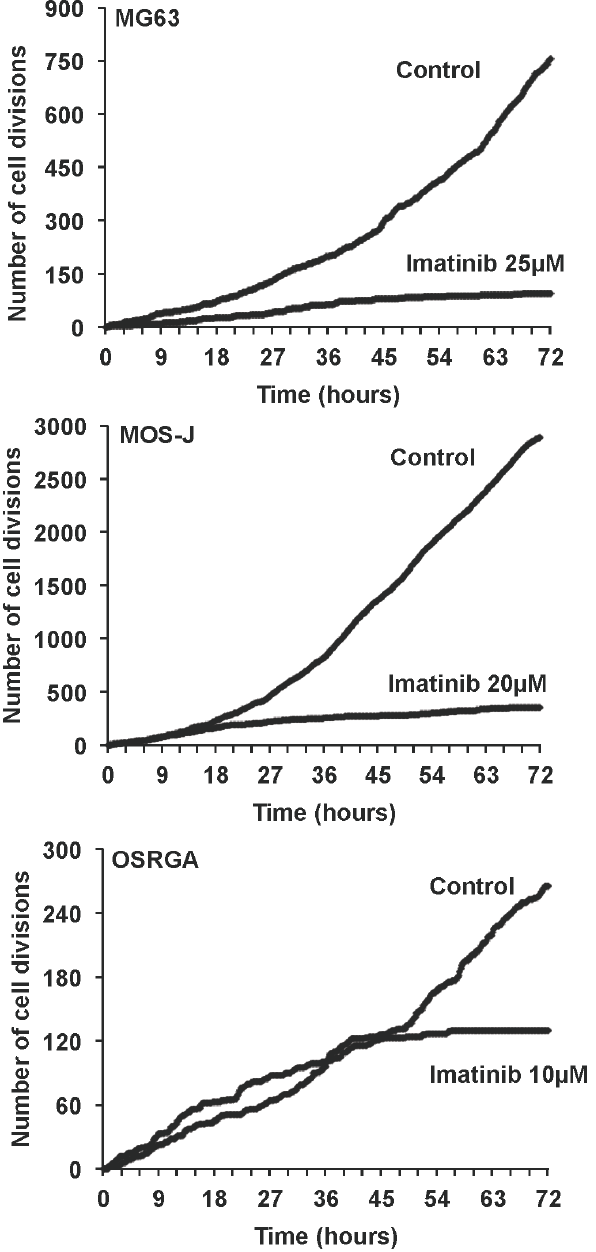
Figure 2. Inhibitory effect of imatinib mesylate on osteosarco- ma cell mitosis. Human MG63 ( A ), mouse MOS-J ( B ) and OSRGA ( C ) osteosarcoma cells were cultured in the presence or absence of imatinib mesylate with 25 m M, 20 m M and 10 m M respectively. Phase- contrast photos were taken every 10 minutes for 72 hours and the number of cell mitosis manually scored in a time-dependent manner. doi:10.1371/journal.pone.0090795.g002 dependent manner the tumour volume compared to the control group (Figure 6A). Rate of tumour progression between days 12 and 21 was also significantly decreased in the treated group compared to the controls (1856 6 281 mm 3 for control mice vs. mice; p , 0.001) (Figure 6B). Similar experiments were carried out using a mixed osteoblastic/osteolytic MOS-J osteosarcoma model (Figure 6C,D). All animal treated with imatinib mesylate (n= 8 per